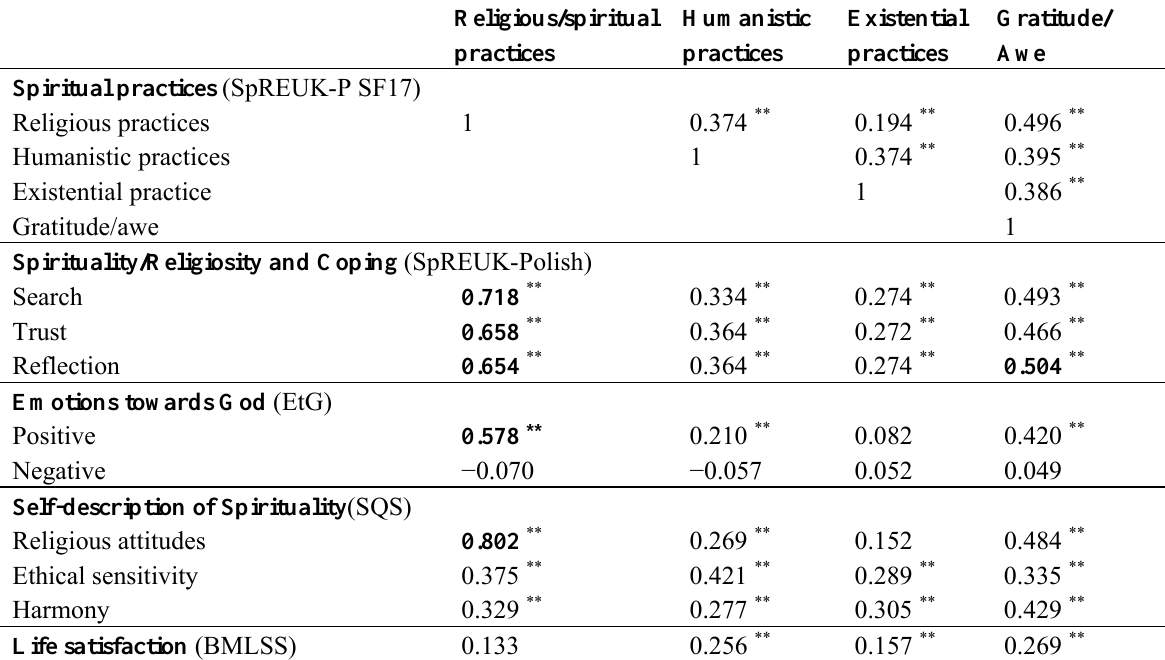
Table 3. Correlation